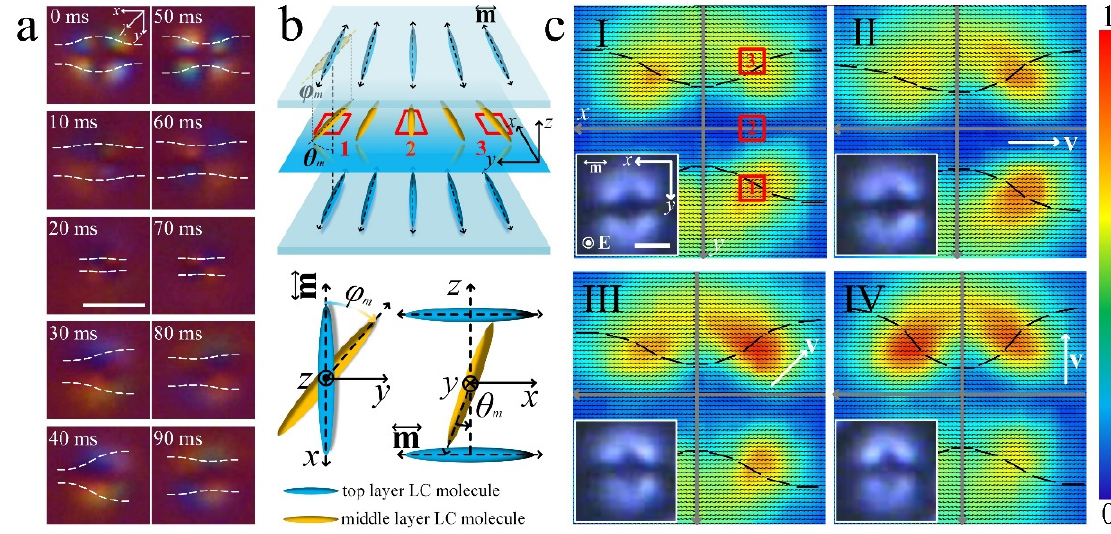
Figure 9. The structure of the dissipative solitons in 5CB. ( a ) Time series of polarizing micrographs of a soliton modulated by an AC electric field. Scale bar 20 μ m. ( b ) The schematic structure of a soliton. m represents the alignment direction. φ m and θ m represent the azimuthal angle and the polar angle of the local mid-layer director. ( c ) Transmitted light intensity maps and the corresponding mid-layer director fields (black dashed lines) in the xy plane within solitons. v represents the velocity of the soliton. The color bar shows a linear scale of transmitted light intensity. Insets are the corresponding POM micrographs, scale bar 10 μ m. Red squares 1, 2, and 3 are corresponding to the ones in ( b ). Reprinted with permission from Ref. [103]. Copyright 2020 Royal Society of Chemistry.